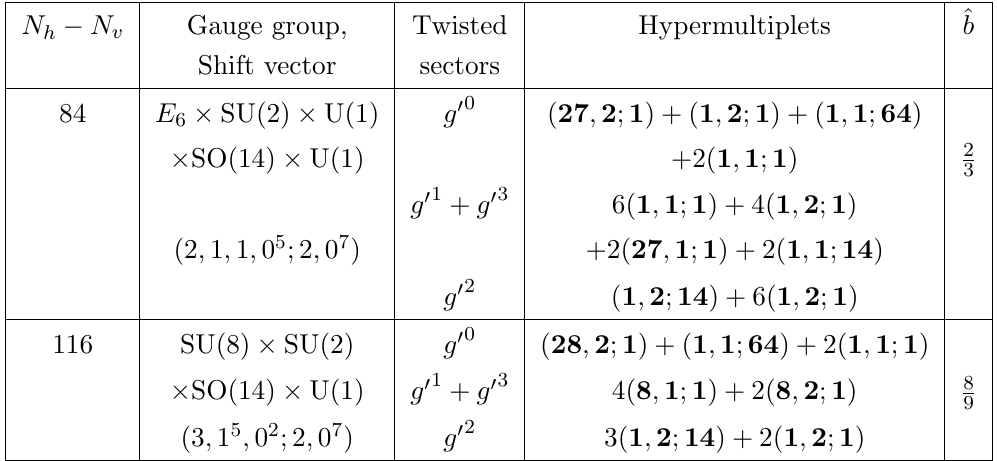
Table 1 . Completely higgsable models used in the examples in section